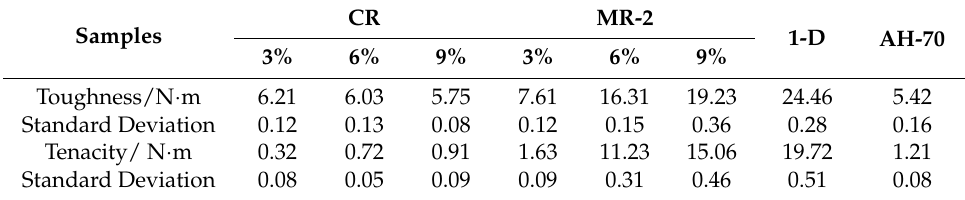
Figure 10. Force–deformation curves for asphalt binder samples: ( a ) aged binder, virgin binder (AH-70) and CR rejuvenated binder (3%, 6% and 9%); ( b ) aged binder, polymer-modified binder (1-D) and MR-2 rejuvenated binder (3%, 6% and 9%). Table 6. Toughness and tenacity of asphalt binders.